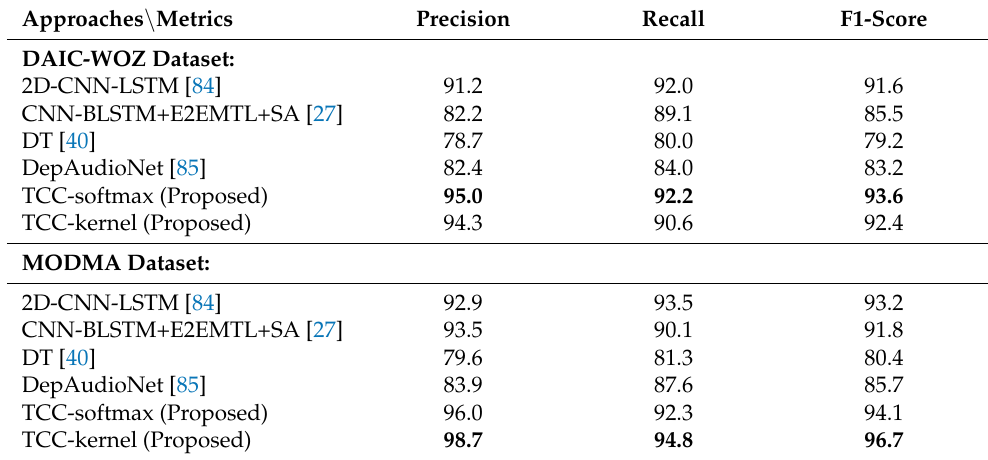
Table 2. The precisions, recalls, and F1-scores (%) of the proposed TCC approach (including ‘softmax’ and ‘kernel’ setups) and the state-of-the-art approaches (2D-CNN-LSTM, CNN-BLSTM+E2EMTL+SA, DT, and DepAudioNet) on the DAIC-WOZ and MODMA datasets.